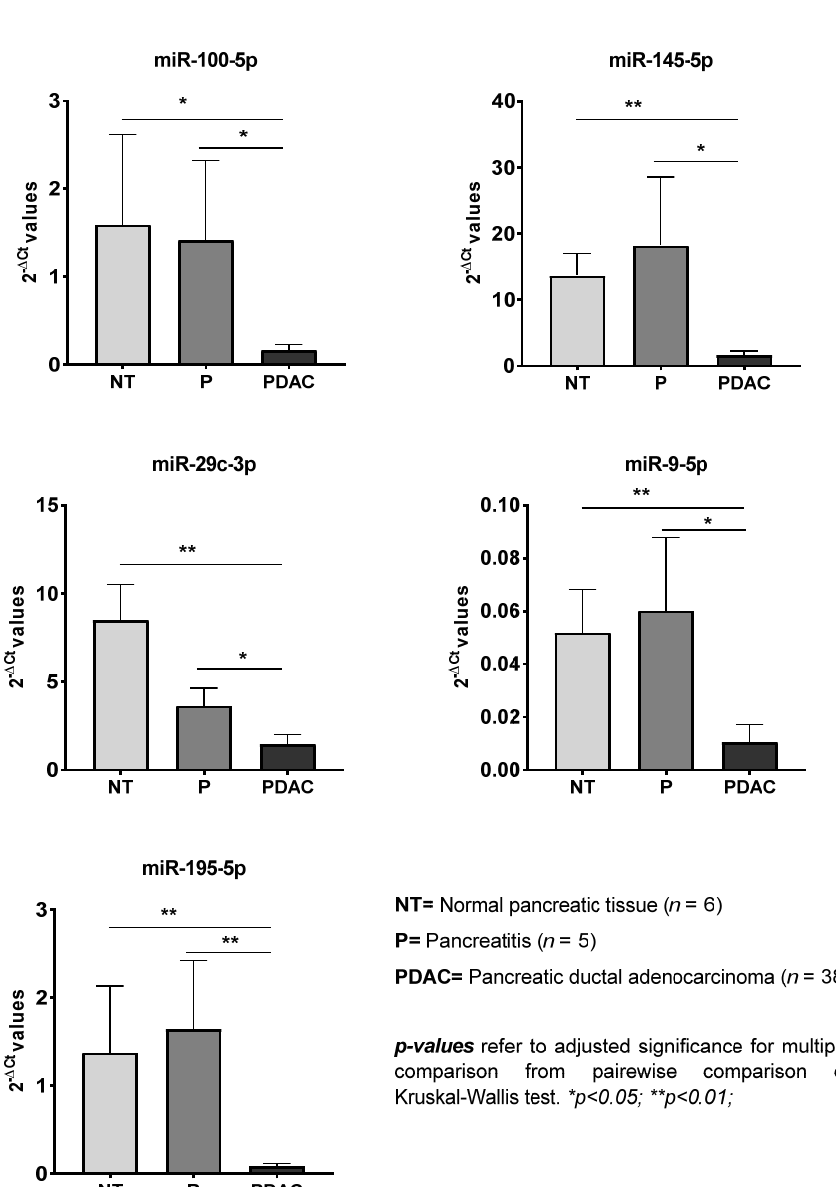
Figure 1. Differential expression of miRNAs in pancreatic tissues from normal (NT), chronic pancre- atitis (P), and pancreatic ductal adenocarcinoma (PDAC) groups. Values are shown as mean ± SEM. Three miRNAs (miR-29a-3p, miR29b-3p, and miR-7-5p) were differentially expressed in the PDAC group as compared with the NT group, but no significant changes were found in the P group (Figure 2).